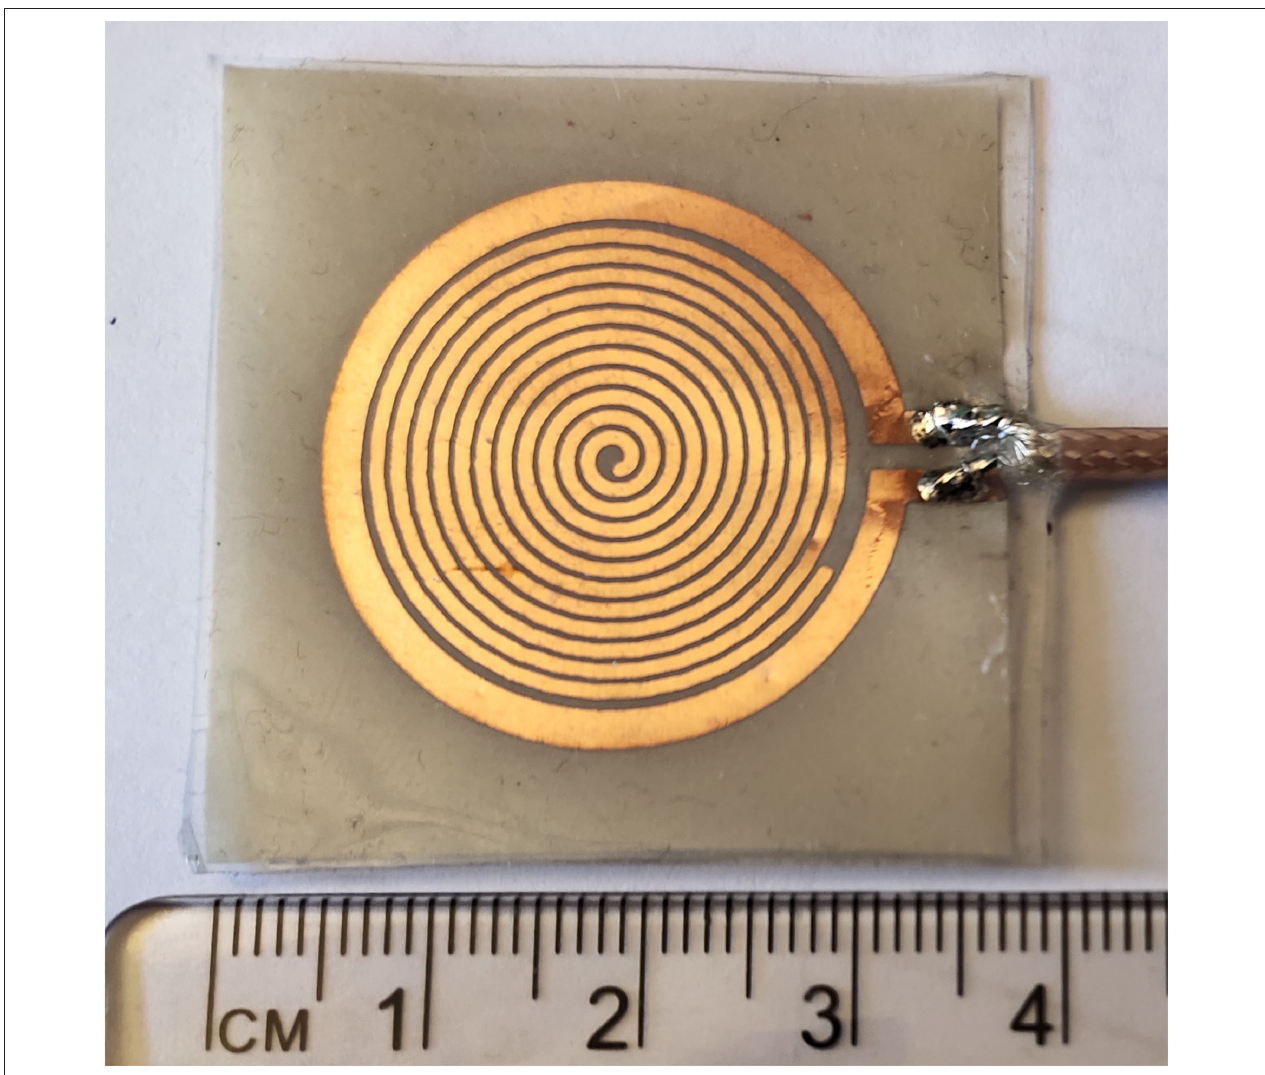
FIGURE 3 | Sensor fabricated